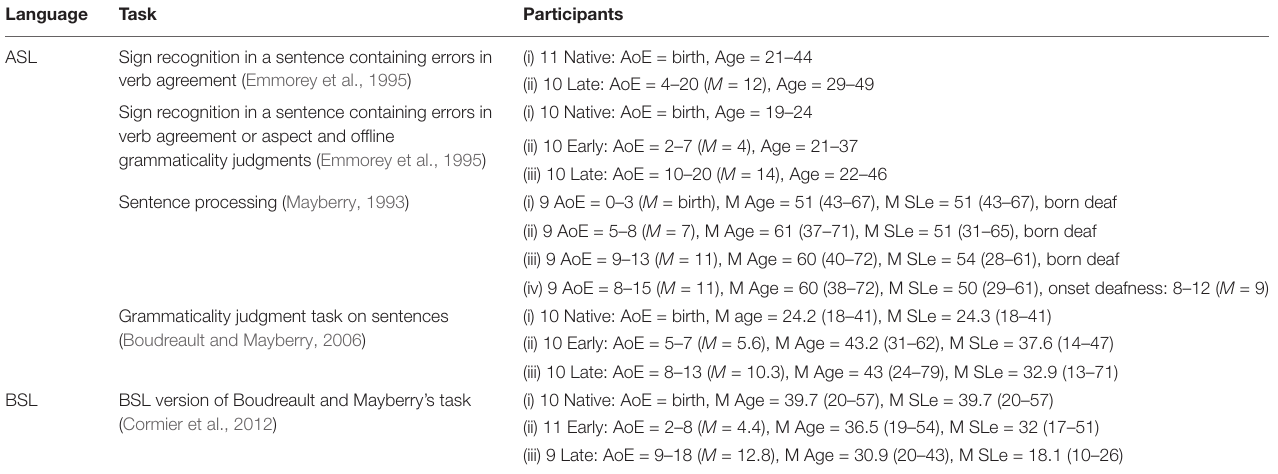
TABLE 1 | Summary of the age of exposure (AoE) of participants across a selection of relevant studies on the impact of AoE. Language Task